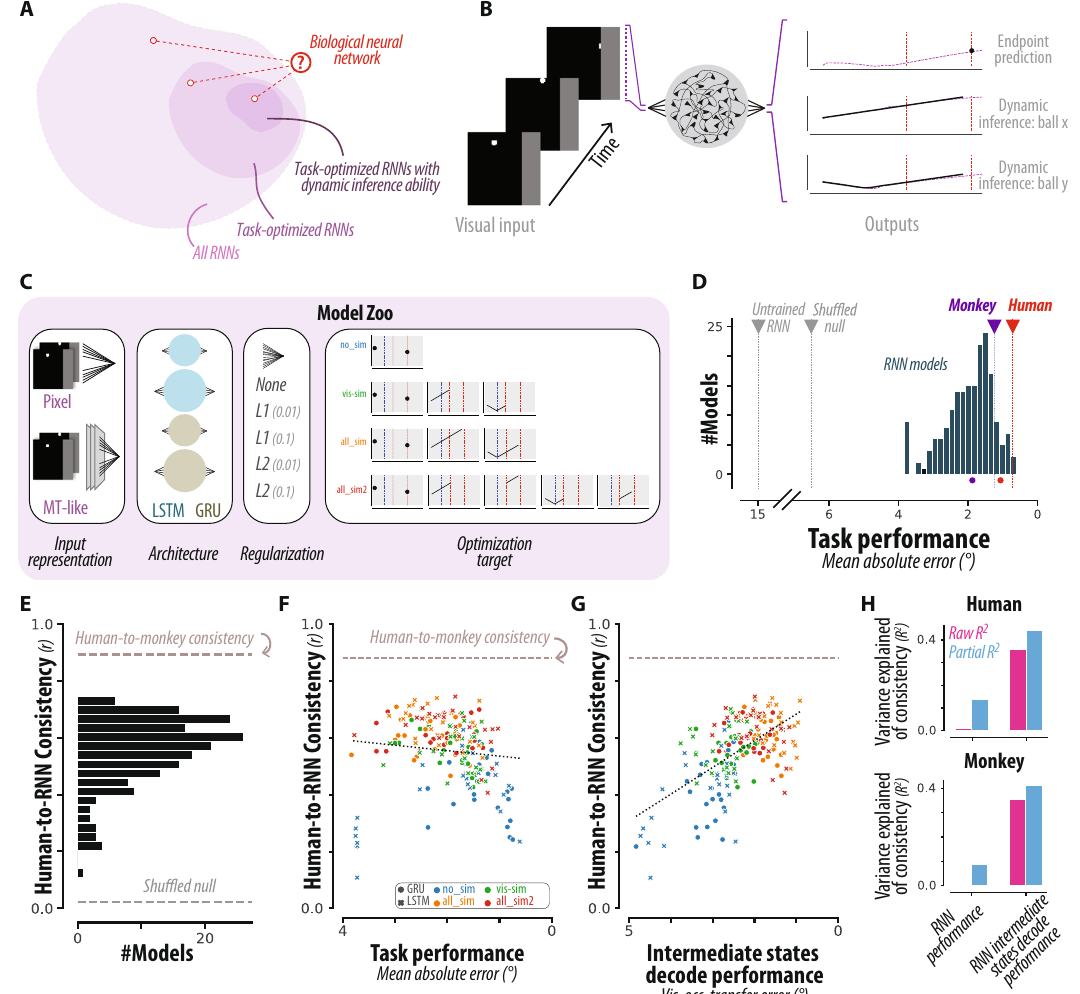
Fig. 3 | Comparing primates and recurrent neural network models. A Conceptual schematic. If primate behavior in this task relies on dynamic infer- ences, then including speci fi c functional constraints (e.g., dynamic inference abil- ity)onRNNsshouldleadto fi ndingmorebrain-likealgorithms. B RNNbehavior.We trained several hundred RNNs to map a series of visual inputs (pixel frames) to an endpoint ball y-position (black dot). Some RNNs were additionally optimized to dynamically track the (x,y) position of the ball throughout the trial (black curves). Thedashed verticallines ontheoutputpanelscorrespondto thetimeofocclusion and the time of the end of the trial. C Full set of RNN hyperparameter choices. Different RNN models varied with respect to architectural parameters and were differently optimized (either with or without dynamic inference ability). Critically, RNNs were not optimized to reproduce primate behavior, only to solve the task. D RNN performance. Distribution of RNN performance on this task. Human/mon- key performance is shown both with (colored circles) and without (colored trian- gles) the inclusion of errors stemming from trial-by-trial variability. Note that the